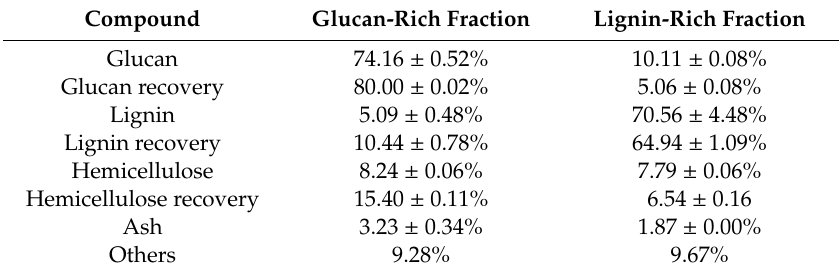
Table 2. Composition of glucan-rich fraction and lignin-rich fraction obtained after acid-catalyzed organosolv pretreatment at 210 °C, for 90 min, and using an S/L ratio of 1:10.